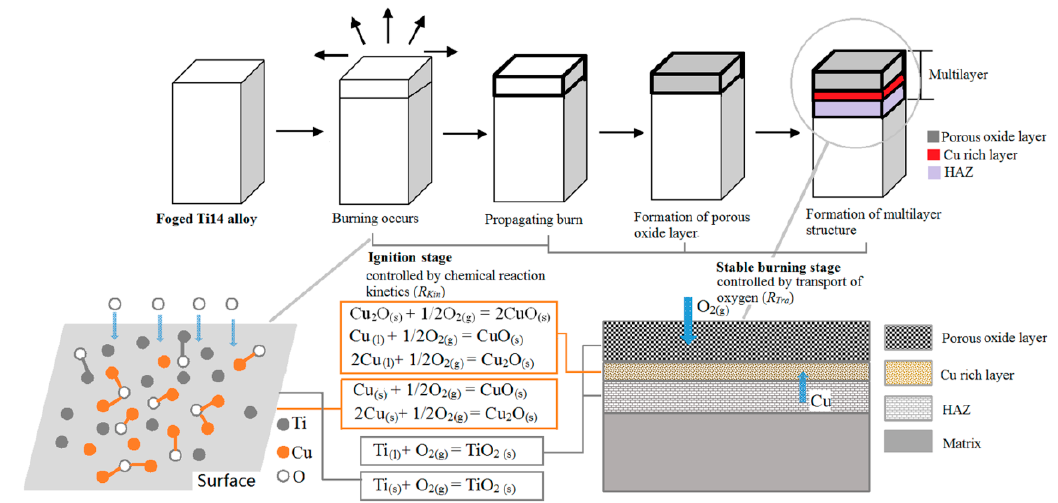
Figure 9. Schematic model showing the role of the Ti 2 Cu precipitates in the forged Ti14 alloy (as generated from the SSP) during the burning process.